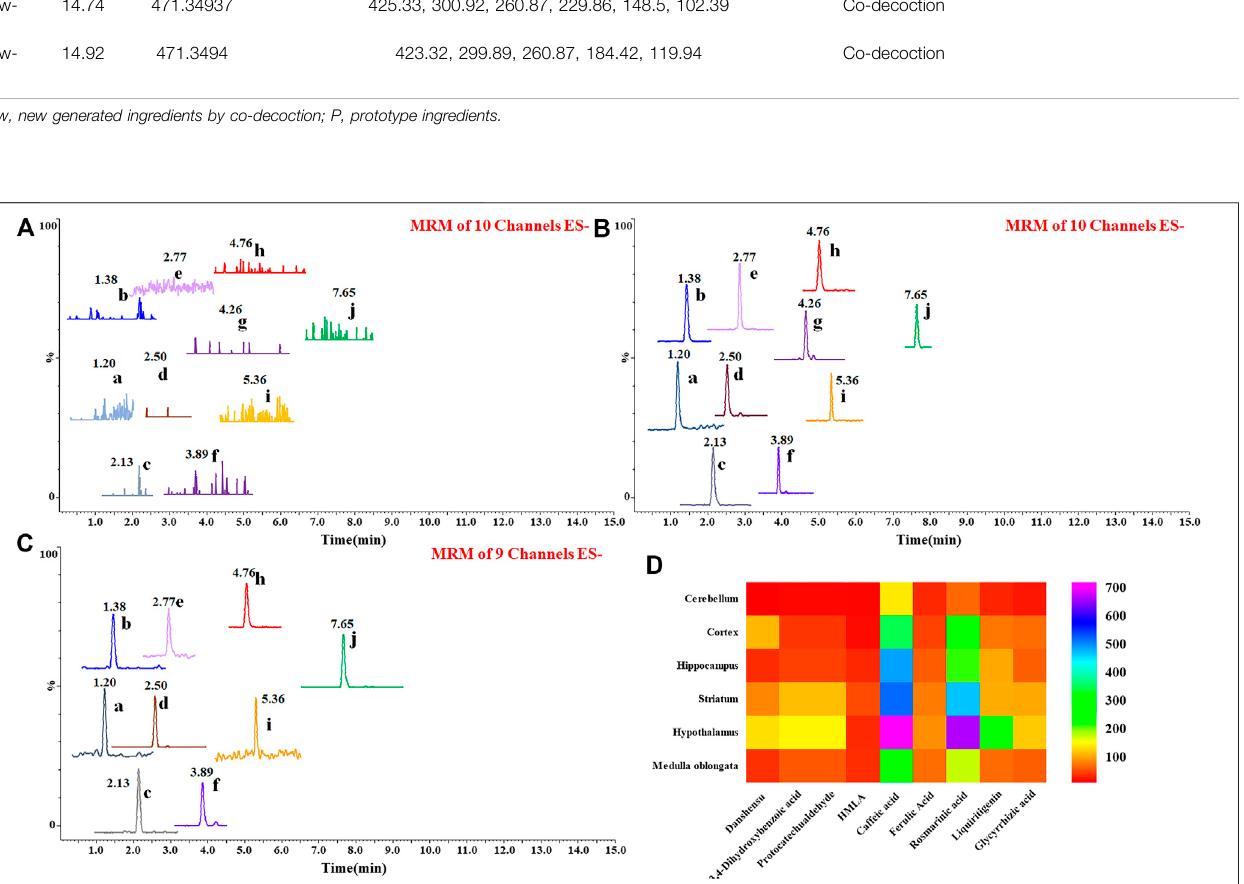
Frontiers in Pharmacology |